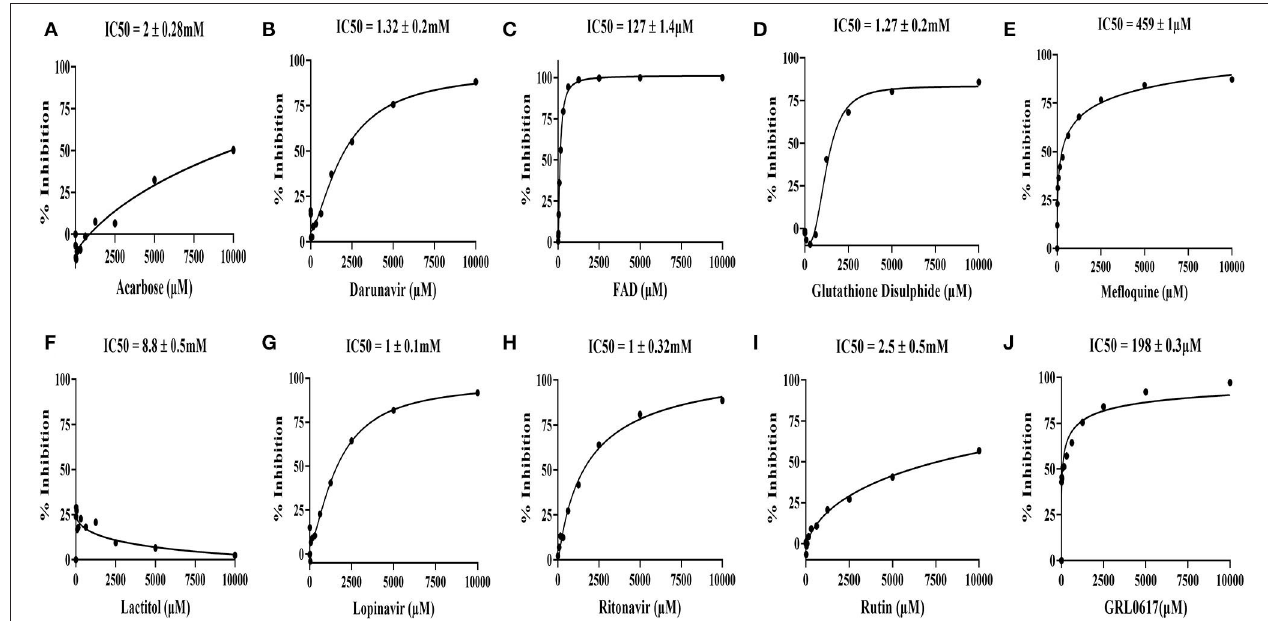
FIGURE 6 | In vitro inhibitory activity of the drugs identified through the virtual screen of the FDA-approved drug library along with GRL0617 inhibitor, a known antagonist of SARS-CoV-2 PLpro. (A) Acarbose, (B) Darunavir, (C) FAD hydrate, (D) Oxidized L-Glutathione disulphide, (E) Mefloquine-HCl, (F) Lactitol, (G) Lopinavir, (H) Ritonavir, (I) RutinTrihydrate, and (J) GRL0617 (5-amino-2-methyl-N-[(1R)-1-naphthalen-1-ylethyl]benzamide). The identified nine molecules with GRL0617 molecules were diluted (10-0 mM) and incubated with PLpro at 37 ◦ C for 45min. After incubation, peptide-AMC substrate reaction was added at 37 ◦ C for 45min to initiate the reaction. Finally, release of the AMC was measured by excitation λ : 364nm; emission λ : 440nm using a microplate reader. The IC 50 values were calculated by the dose-response-inhibition function by GraphPad prism software. The assay experiments were performed in biological